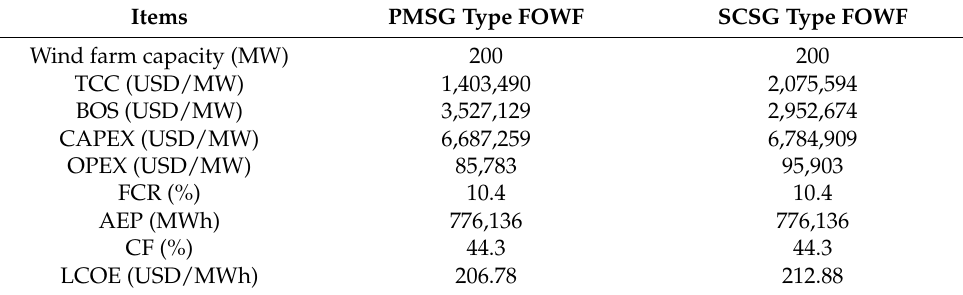
Table 14. The LCOE of the PMSG and SCSG type FOWFs.